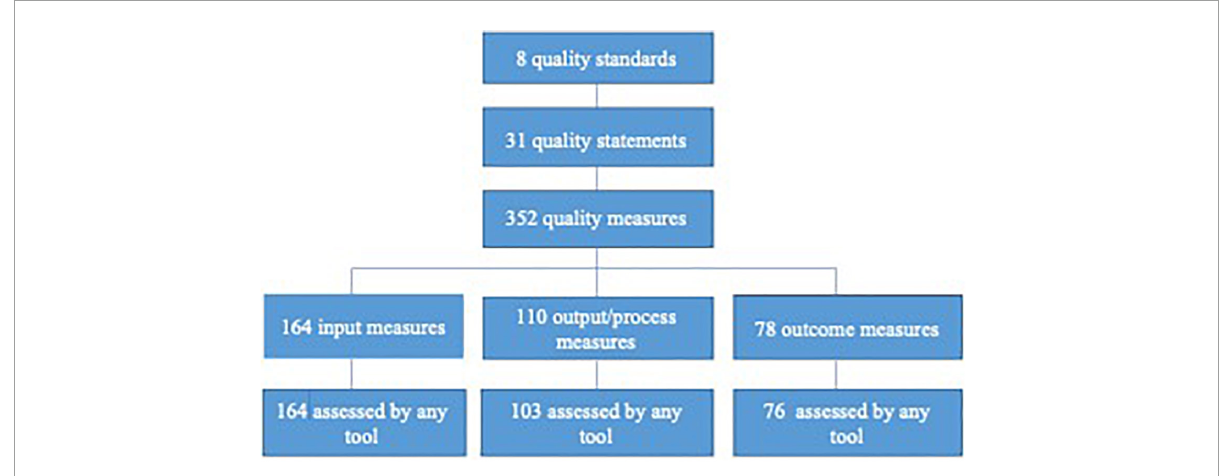
FIGURE1 WHO/UNICEF/UNFPA quality of care standards, statements and